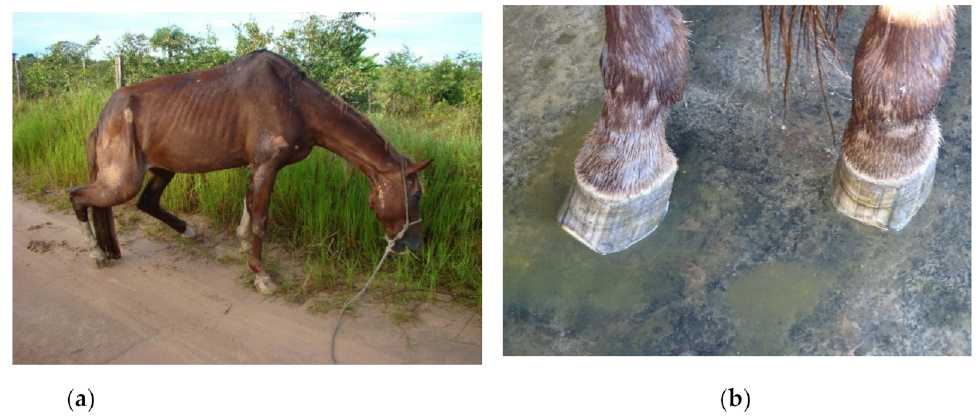
Figure 2. Clinical signs in horses with equine herpesvirus myeloencephalopathy in the state of Par á , Amazon, Brazil: ( a ) animal with sloping croup, abduction and pelvic limb paresis (“crouched posture”); ( b ) animal with moderate dragging of the toe of pelvic limbs, due to dragging on a concrete